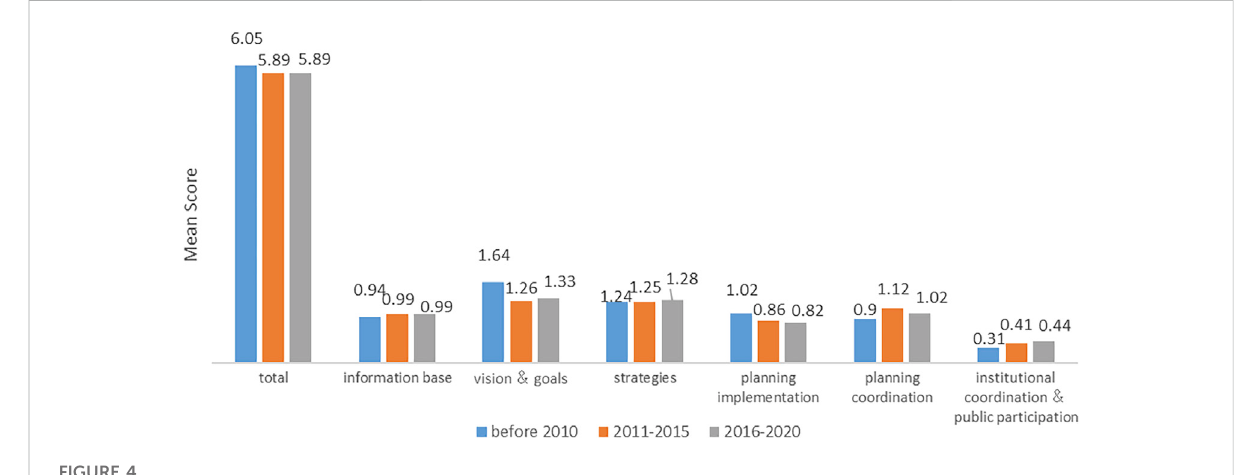
FIGURE 4 Comparison of formulation time.